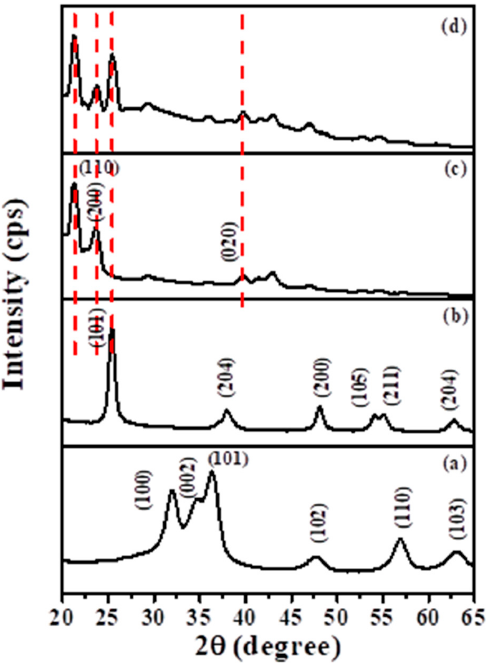
Figure 1. XRD diffractogram of materials: ( a ) ZnO QDs, ( b ) ZT, ( c ) bare LLDPE, and ( d ) 8%-ZT@LLDPE.